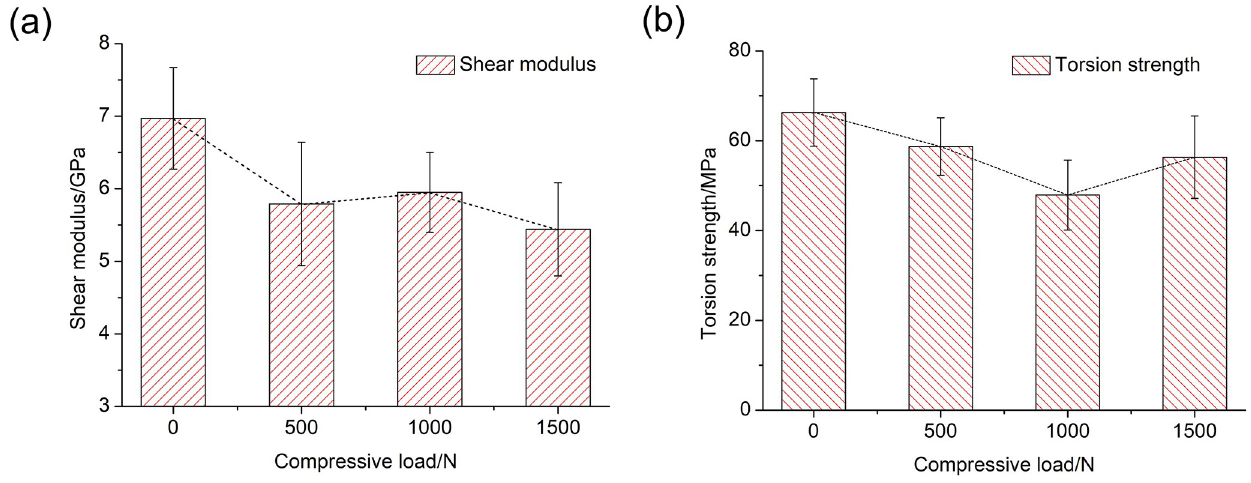
Fig 3. Variations of shear modulus and torsion strength with different compression